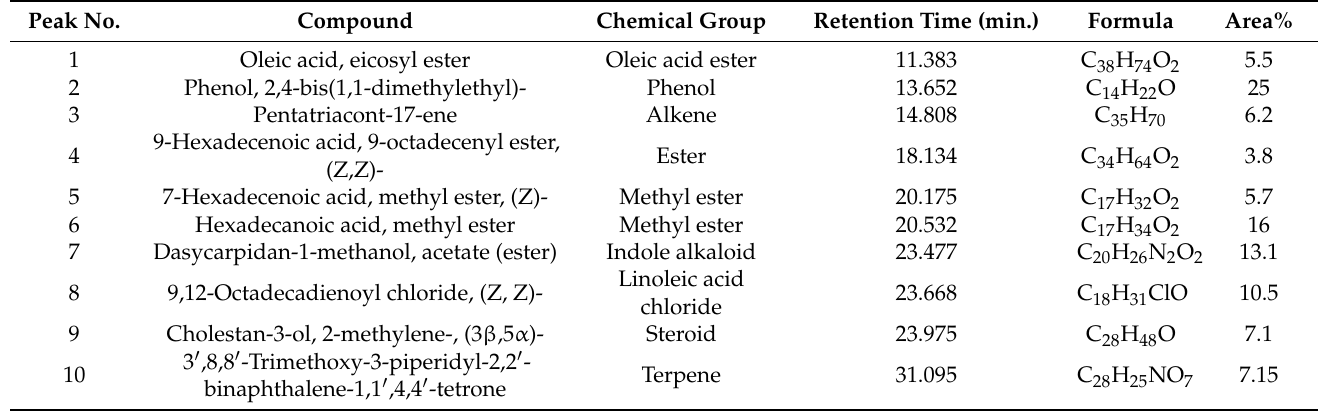
Figure 7. GC chromatogram of O. sancta crude extracts grown on T3. Table 4. The data of GC-MS analysis of methylene chloride/methanol crude extract of O. sancta grown on 12.5% modified Zarrouk’s medium